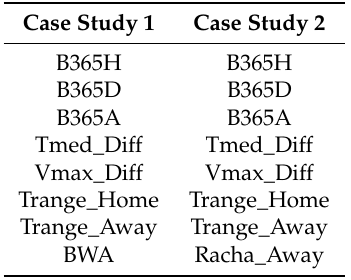
Table 4. The final features of the proposed models including weather features.